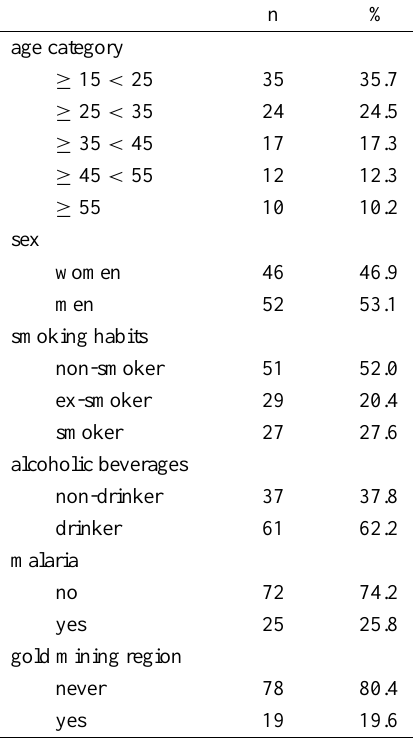
Characteristics of the study